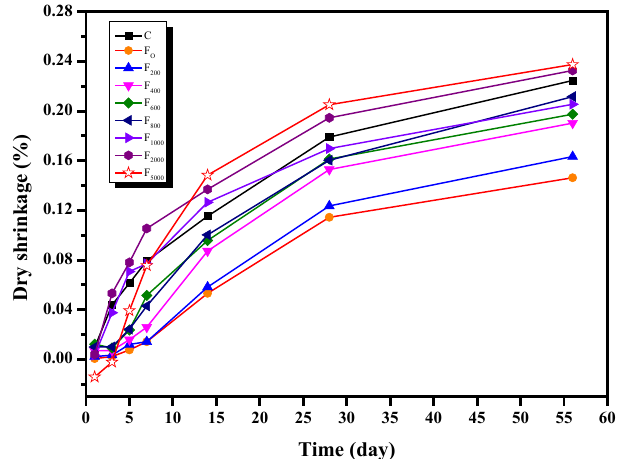
Figure 11. The effect of increasing fly ash ammonia content on the drying shrinkage of cement paste.